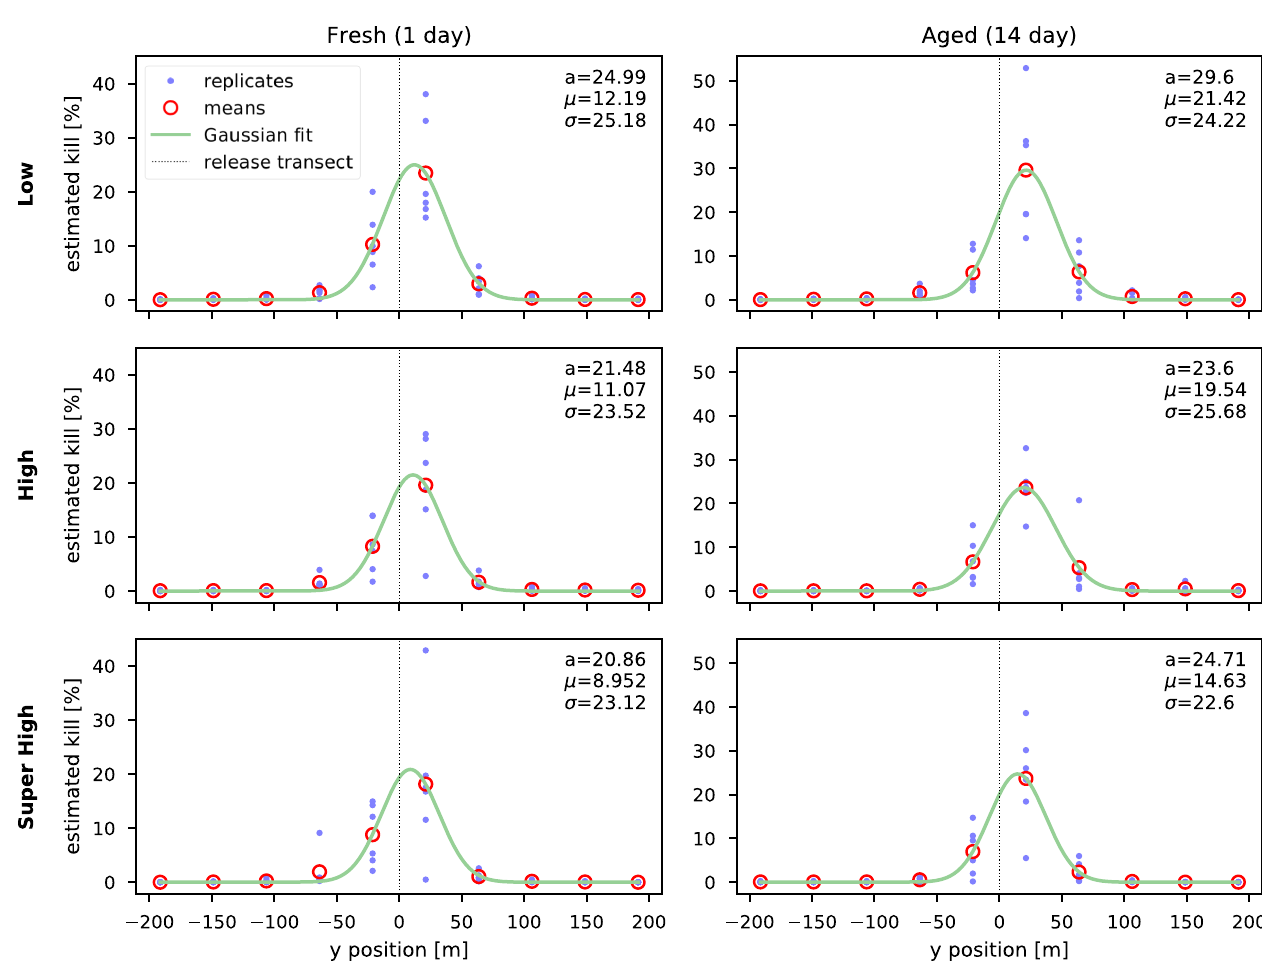
Fig 2. Relationship between distance from release transect on estimated percentage of males killed. Each panel is a combination of density treatment (rows) and MAT age (columns). For each replicate, the total estimated percentage of the males killed (including male kills for hats) for each row of traps is shown with a blue dot. The x axis is the position of the rows relative to the release transect. The mean for all six replicates at each trapping row is shown by a red circle. A Gaussian function was fitted to the data and is shown by the green line and the fit parameters given in the upper left of each panel.